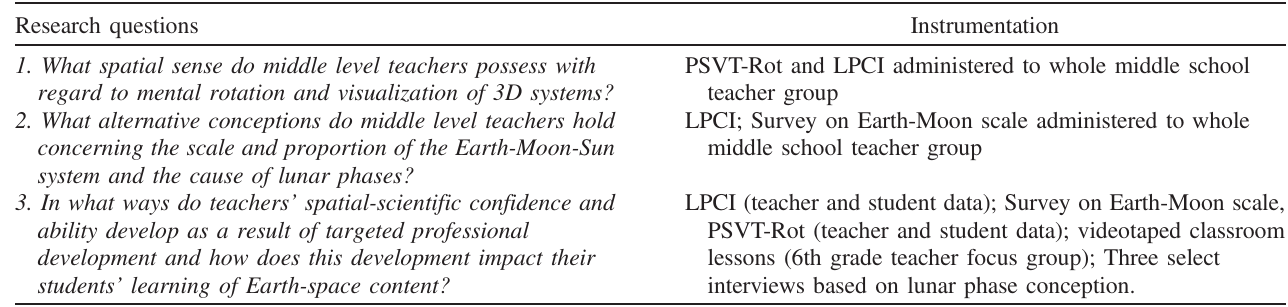
TABLE III. Research questions with corresponding data collection, instrumentation, and sample population. Research